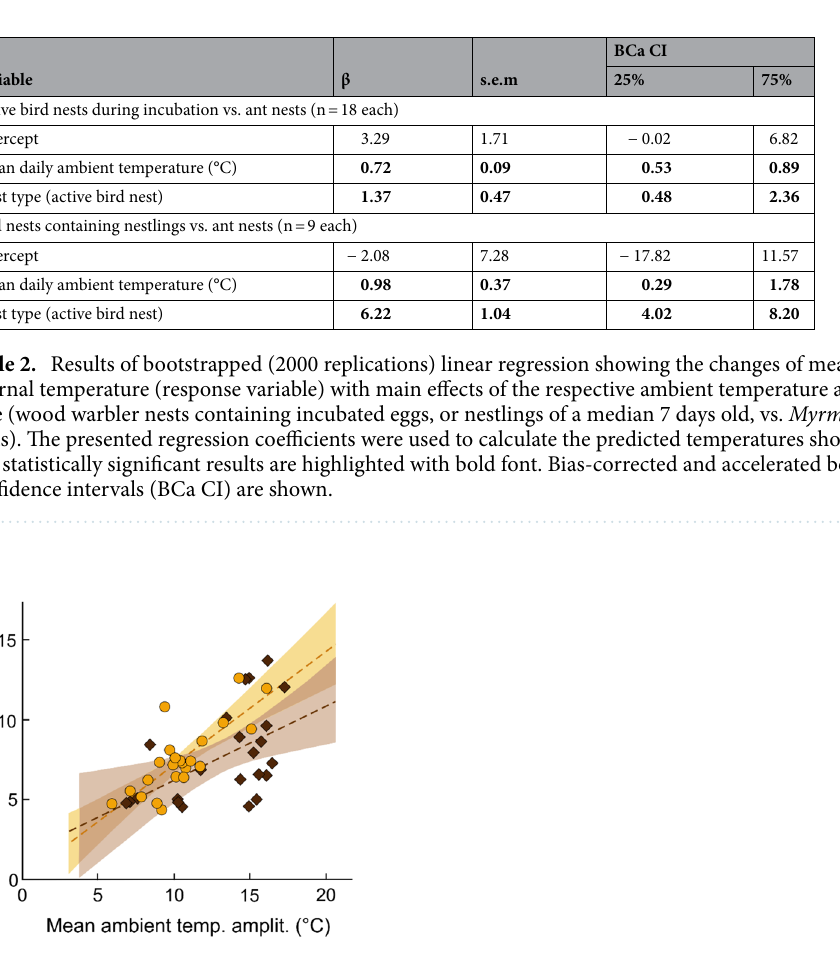
Figure 3. The changes of mean daily internal temperature amplitude (the difference between maximum and minimum mean hourly temperatures in a day) in relationship to mean daily ambient temperature amplitude in vacant nests of wood warblers (yellow circle, n = 23) and in occupied Myrmica ant nests (brown diamond, n = 23) in 2019. Dashed lines show trends and shaded areas are 95% confidence intervals.